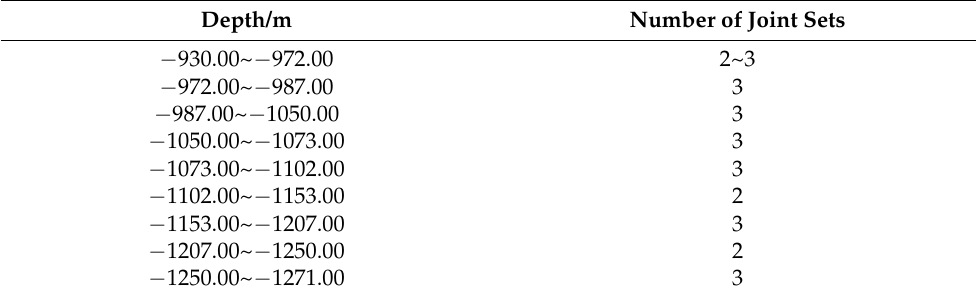
Table 2. Number of joint sets at different depths.